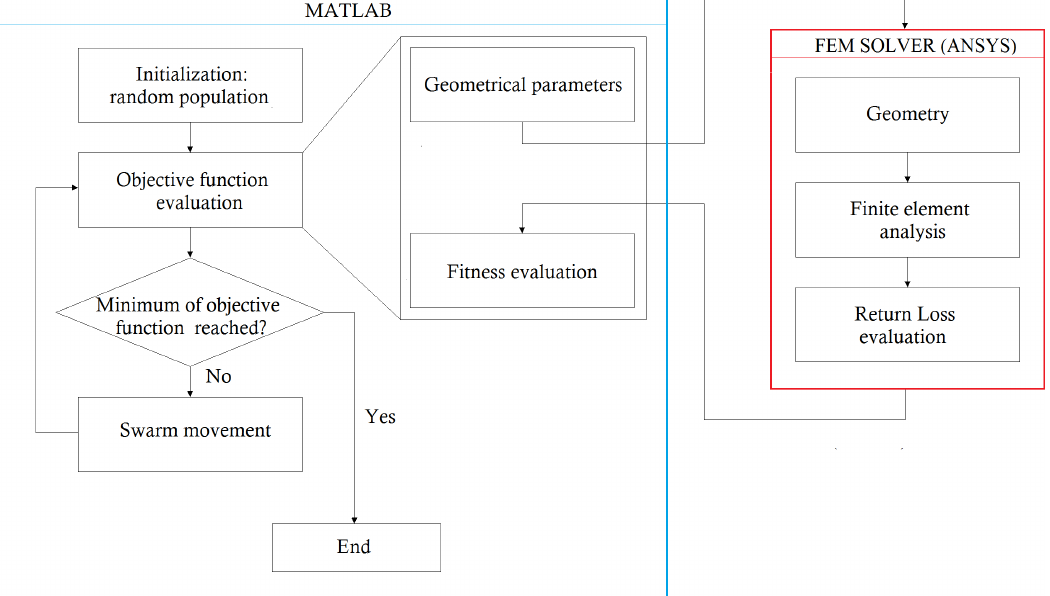
Figure 5. Summary of the PSO-based optimization algorithm for the Chebyshev transformer [33].